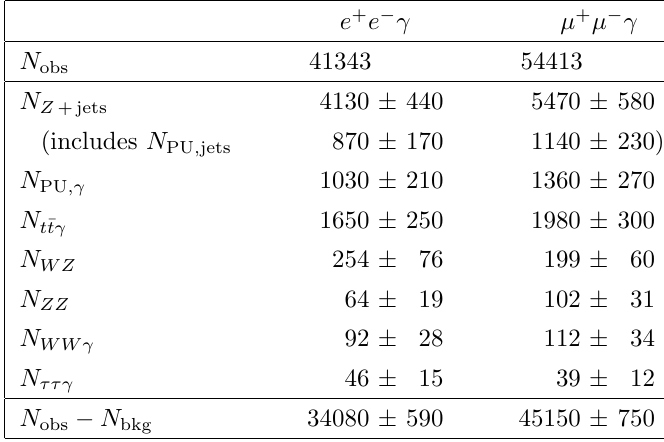
Table 3 . Summary of the observed number of events ( N obs ), and the estimated number of back- ground events ( N Z +jets ; N PU ;(cid:13) ; N ; N WZ ; N ZZ ; N WW(cid:13) ; N (cid:28)(cid:28)(cid:13) ), in the e + e (cid:0) (cid:13) and (cid:22) + (cid:22) (cid:0) (cid:13) t (cid:22) t(cid:13)